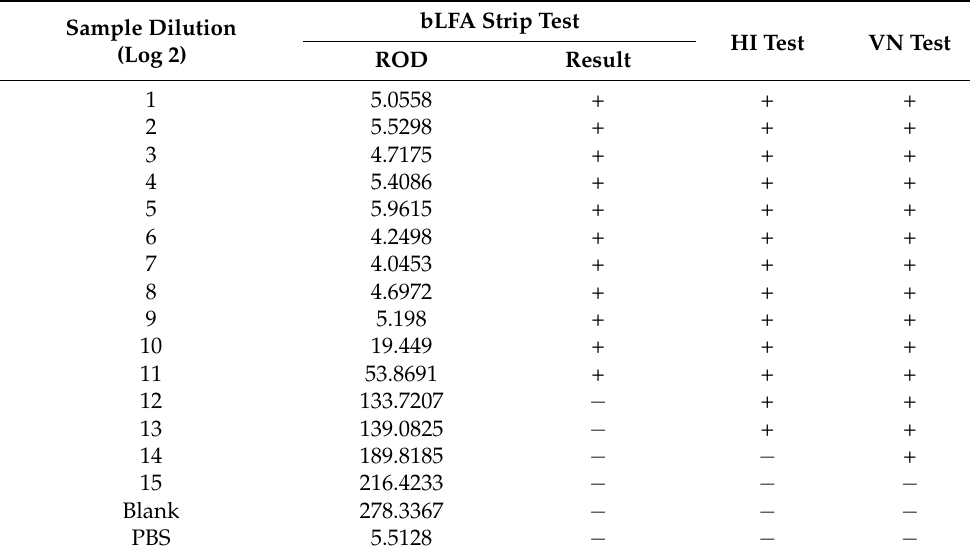
Notes: + = positive; − = negative; HI = hemagglutination inhibition; PBS = phosphate-buffered saline: ROD = relative optical density; VN = virus neutralization; blank = containing HN protein without serum sample.